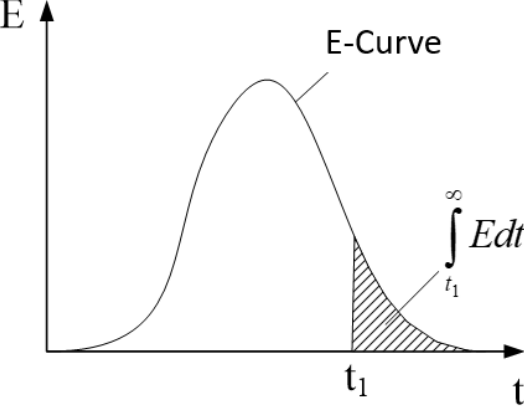
Figure 1. Residence-time distribution (RTD) Figure 1. Residence ‐ time distribution (RTD) function.